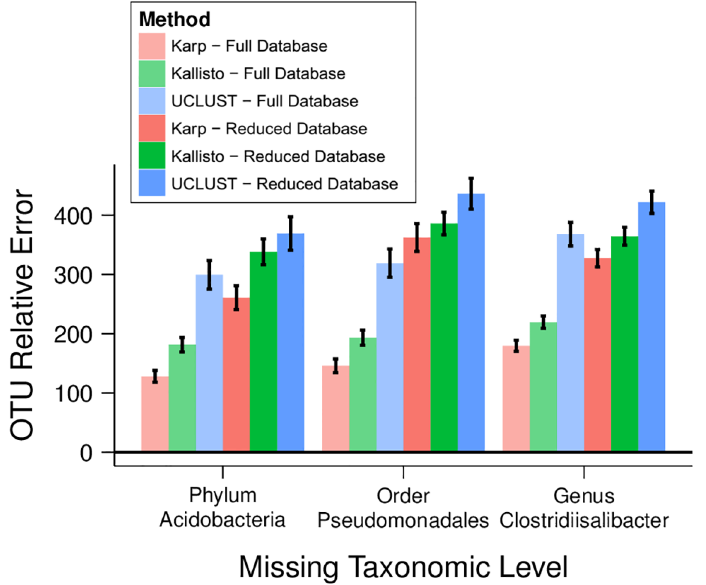
Fig 4. Results with missing taxa. Accuracy when the reference database used for quantification is missing taxa found in the sample. For each of one phylum ( Acidobacteria ),one order ( Pseudomonadales ), and one genus ( Clostridiisalibacter ), 10 samples were simulated where 50% of the reads originated from the noted taxa. Each sample was classified with the full GreenGenes database and also a reduced version of the database lacking all members of the taxa which had been used to simulate the sample. The accuracy of estimates by Karp, Kallisto, and UCLUST for the 50% of the samples that did not originate from the absent taxa were compared with their true frequencies. Black bars give 95% confidence intervals.